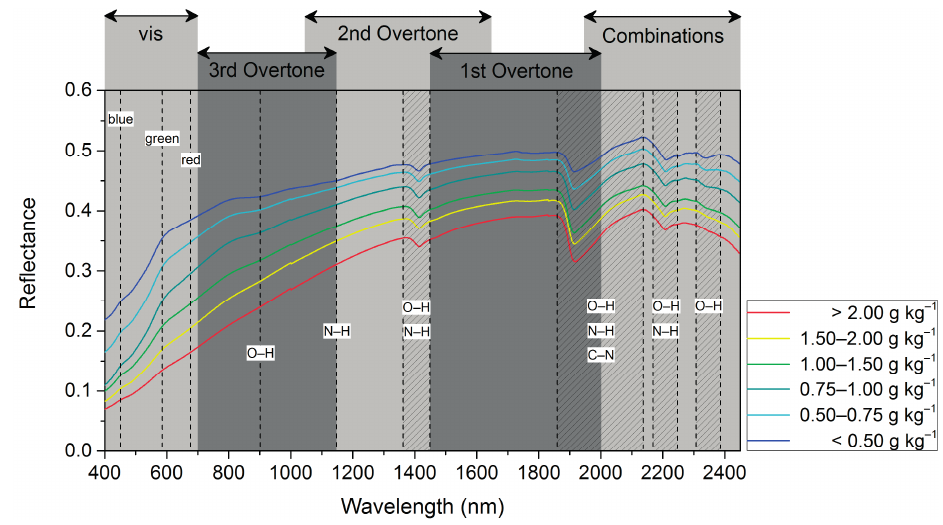
Figure 2. Mean reflectance of total nitrogen concentration for different